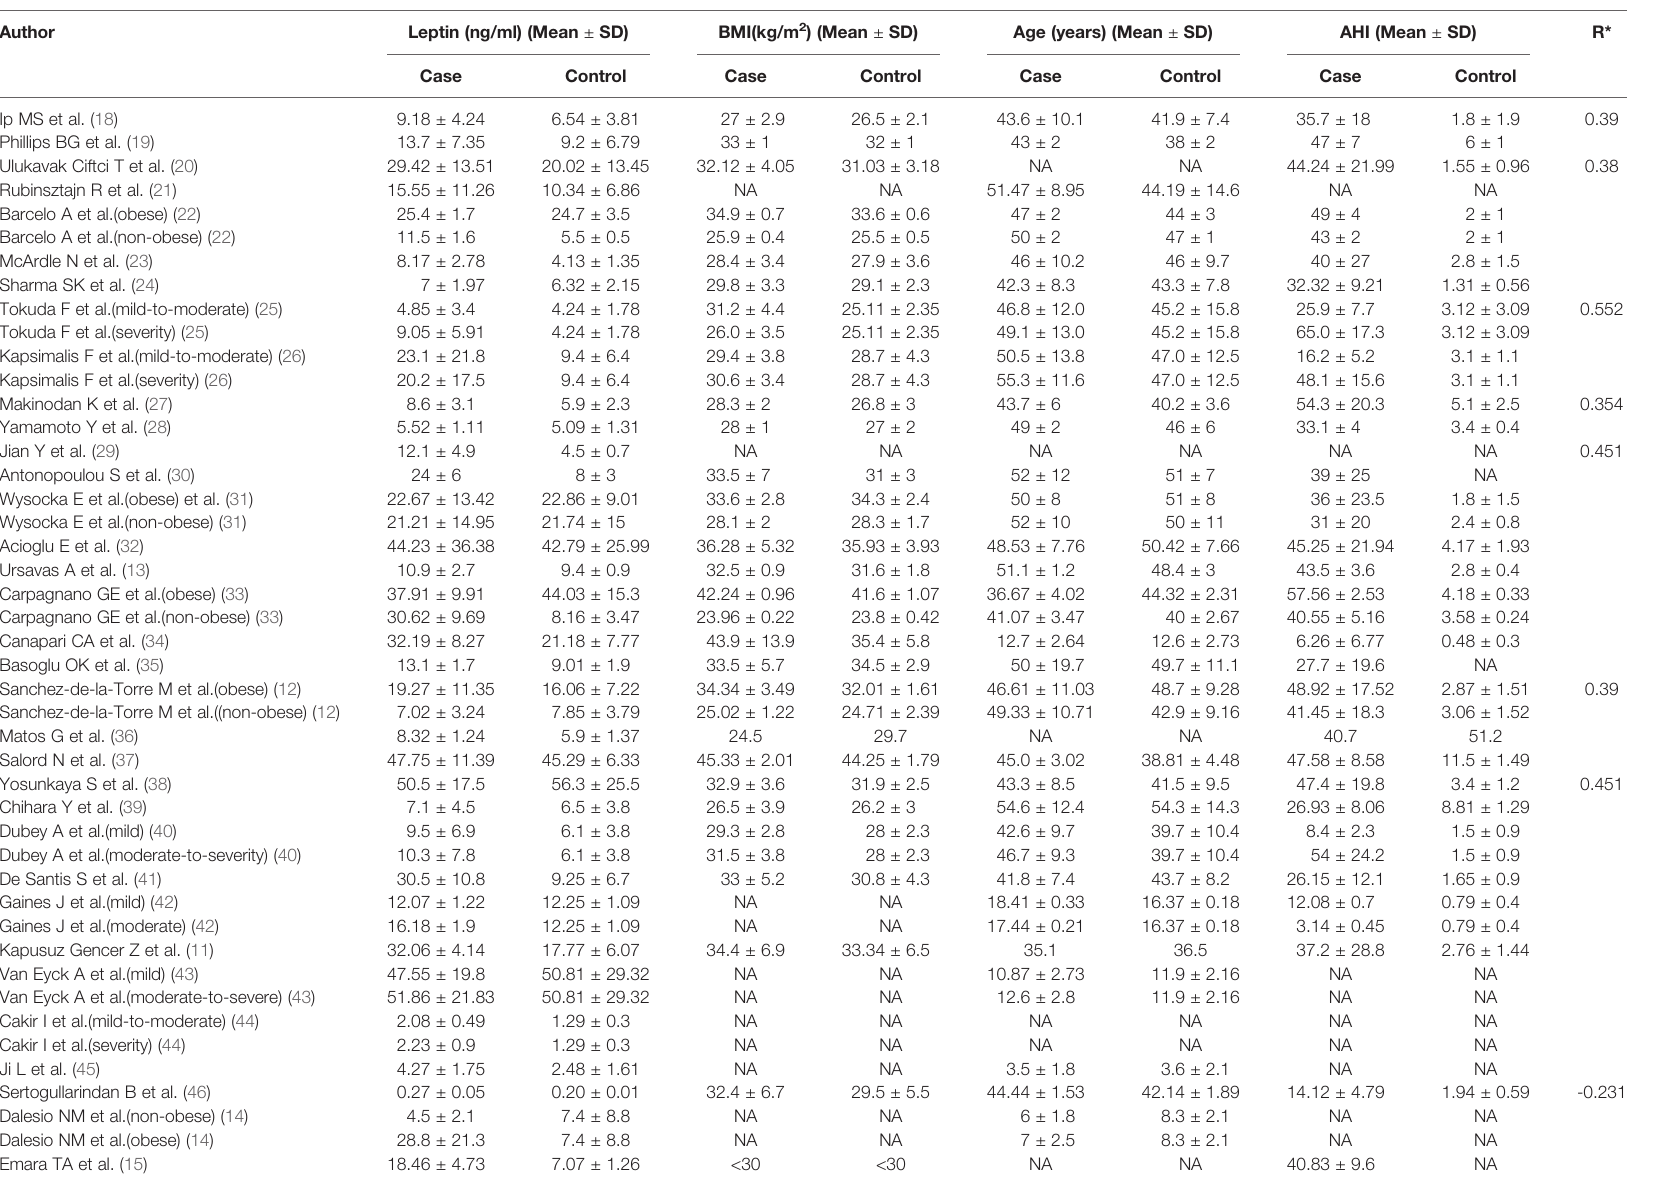
TABLE 2 | Participants ’ characteristics of included studies.